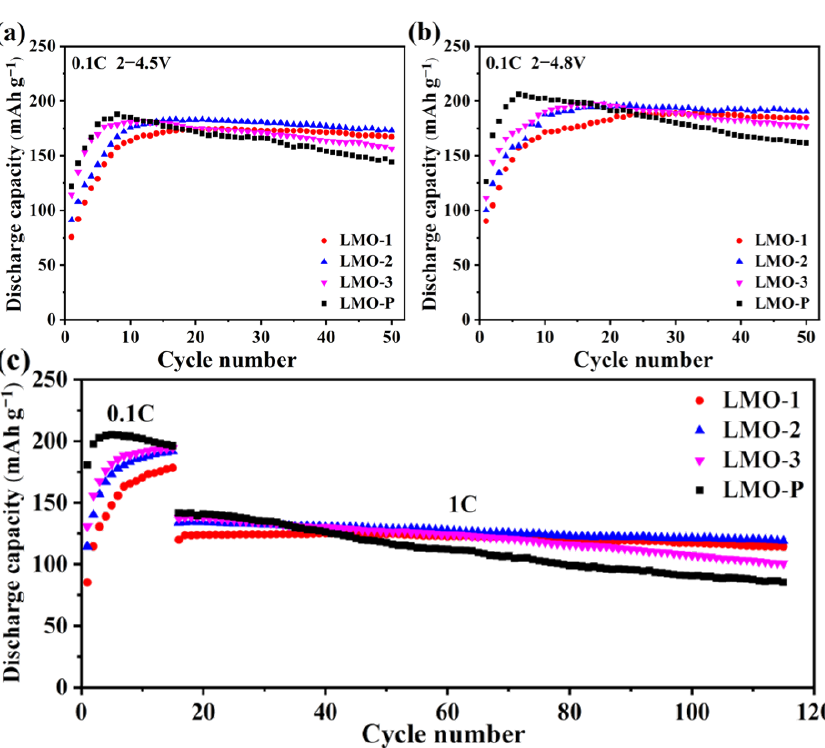
Figure 6. Cycling performance at 0.1 C with the 2.0 – 4.5 V range ( a ), 0.1 C with the 2.0 – 4.8 V range ( b ), and 1 C with the 2.0 – 4.8 V range ( c ).